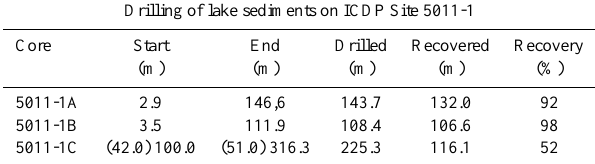
Table 1. Information on drilling of sediments from cores 1A, 1B and 1C from ICDP Site 5011-1 in Lake El’gygytgyn. In core 1C sediments were first recoved from 42 to 50m (shown in brackets) to patch up gaps in sediment recovery in cores 1A and 1B. After that drilling was continued at a depth of